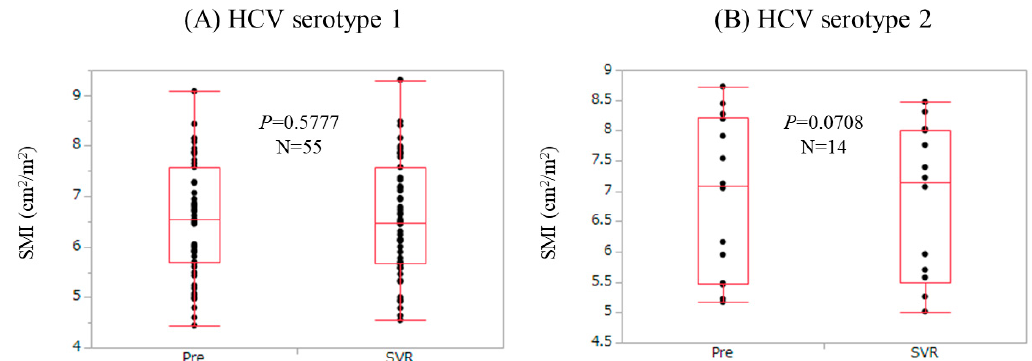
Figure 3. Changes in SMI according to HCV serotype. ( A ) In the HCV serotype 1 group ( n = 55), SMI at SVR did not significantly increase as compared with baseline levels ( p = 0.5777); ( B ) In the HCV serotype 2 group ( n = 14), SMI at SVR tended to significantly decrease as compared with baseline levels ( p = 0.0708).